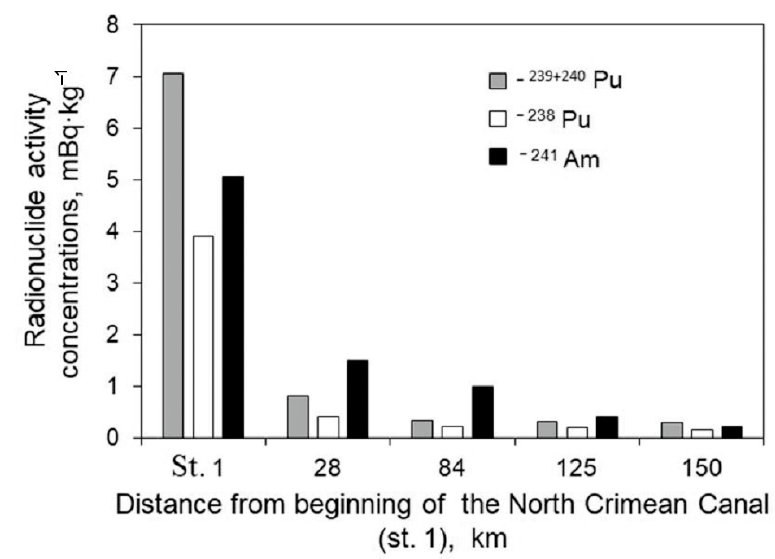
Figure 9. Changes in the activity concentrations of technogenic radionuclides in the suspended matter (d.w.) of the Dnieper water with increasing distance from the beginning of the NCC. Their values decreased as the distance from the beginning of the NCC increased.